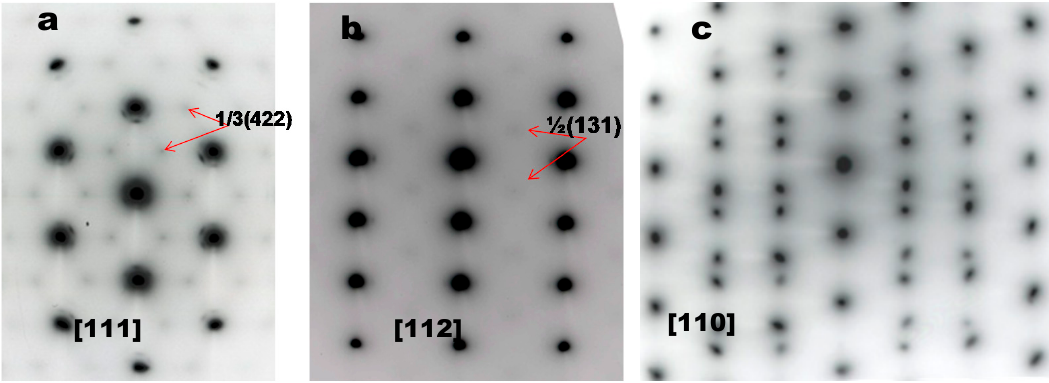
Figure 6. Diffraction patterns taken along the [111], [112] and [110] zone axes of Alloy 600 after stress corrosion cracking tests in 360 °C water (reproduced from [3] with permission from YS Kim, 2019).